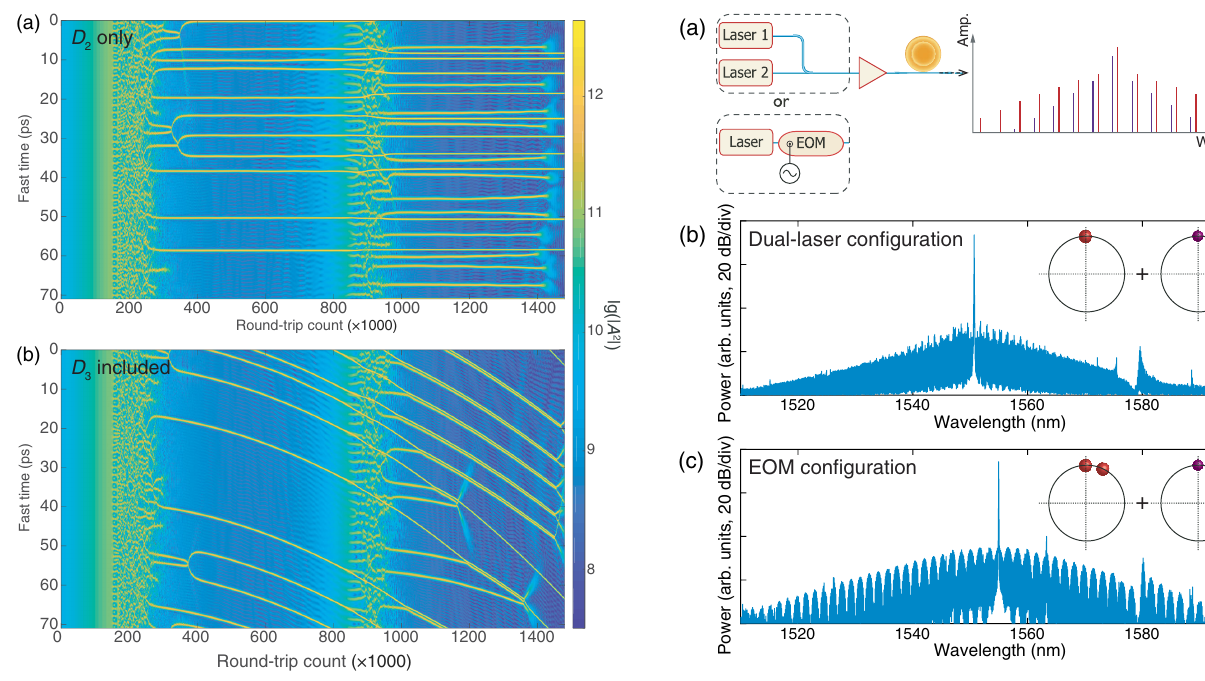
FIG. 11. Simulated intracavity intensity evolutions with two lasers driving one cavity resonance. (a) Only second-order dispersion ( D 2 ) is considered in the simulation. (b) Third-order dispersion ( D 3 ) is also included in the model. All the parameters used in the simulations are the same as those used for obtaining the results shown in the lower panel in Fig. 1(f), except that both lasers are driving the same cavity resonance of μ ¼ 0 .